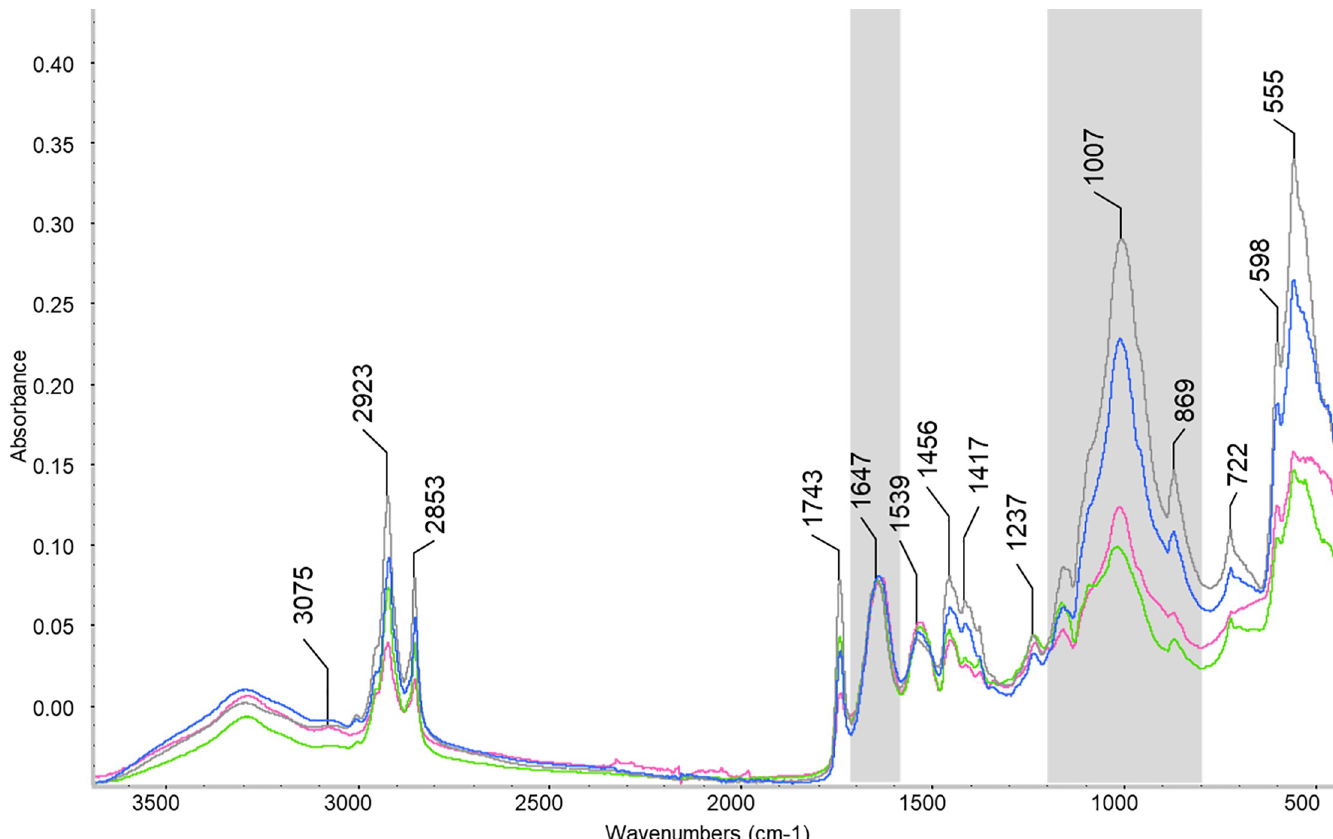
Fig 8. Demineralization of bone of specimen stained in Lugol’s iodine. Overlay of the ATR-FTIR spectra of I 2 KI in water stained bird bone (657965). Prestained (gray), interim sample (blue), post-stain (light green), and de-stained (pink). The phosphate ν 1 and ν 3 of PO 4 − 3 region is shaded in gray. Normalized to the Amide I peak from collagen at 1647 cm -1 (also shaded in gray).